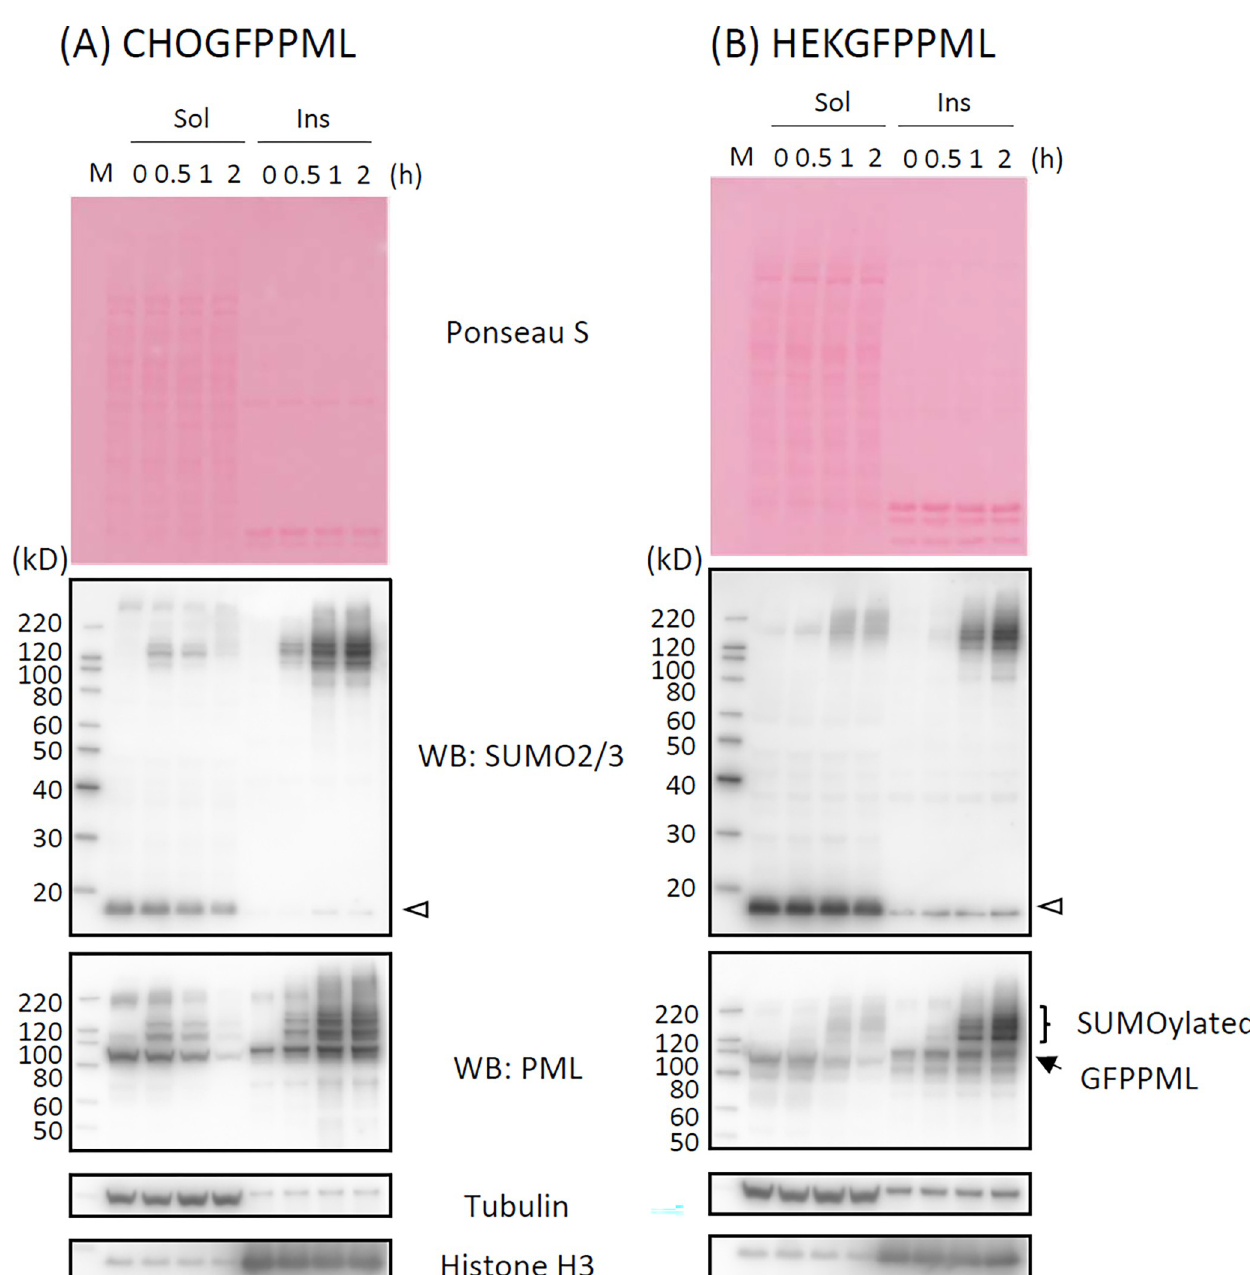
Fig 6. Time–course changes in the solubility and SUMOylation of PML following exposure to 3 μ M As 3+ in CHOGFPPML (A) and HEKGFPPML cells (B). The cells were exposed to 3 μ M As 3+ for 0 (untreated), 0.5, 1, and 2 h. SUMOylation of GFPPML was observed in the RIPA–soluble fraction (Sol) after 0.5 h– exposure. The solubility of unmodified GFPPML decreased after 1 h, and most of the GFPPML and SUMOylated GFPPML was recovered in the RIPA– insoluble fraction (Ins) after 2 h–exposure to As 3+ . An open arrowhead indicates SUMO2/3 monomers. interest to note that the ratio of SUMO2/3 to PML of the peri-nuclear PML aggregates was lower than that of PML-NBs regardless of As 3+ -exposure in the absence of ML792 as judged by the relative fluorescence intensities (arrows, Fig 10). In contrast, the SUMO/PML ratio was almost the same between peri-nuclear PML aggregates and PML-NBs when the cells were pre-